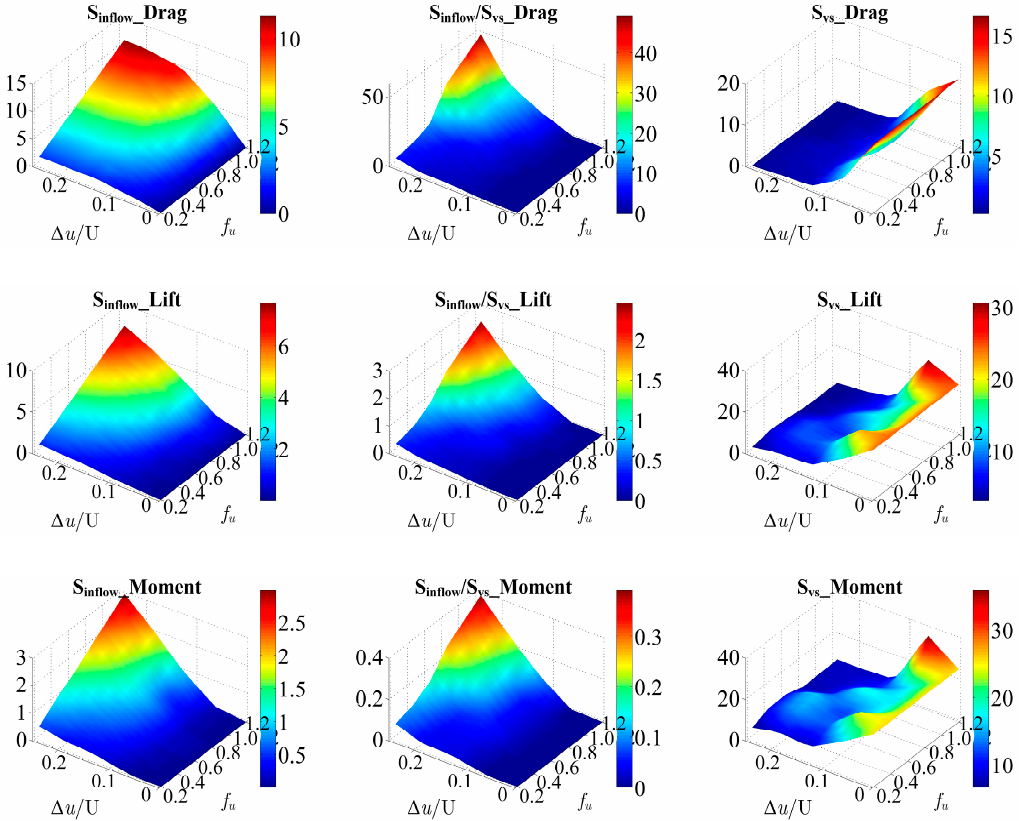
Figure 10. Effects of f u and Δ u /U on the inflow oscillation-contributions (left column), on the vortex shedding-contributions (right column), and on the ratios between the two contributions for drag, lift, and moment. Results are taken at AoA = 4° for instance.